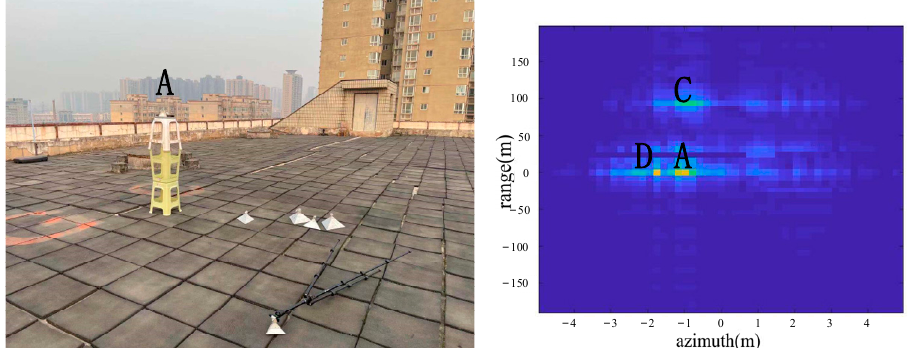
As shown in Figure 11, a corner reflector A was placed in the azimuth direction 17 m